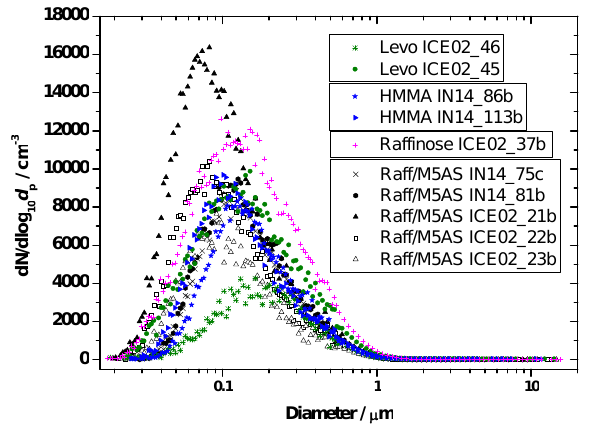
Fig. 2. A comparison of size distributions of aerosols taken imme- diately prior to experiments shown in Fig. 7. The average of the mean volume-equivalent sphere diameters ( d p ) of the aerosols was 0.170 ±0.027